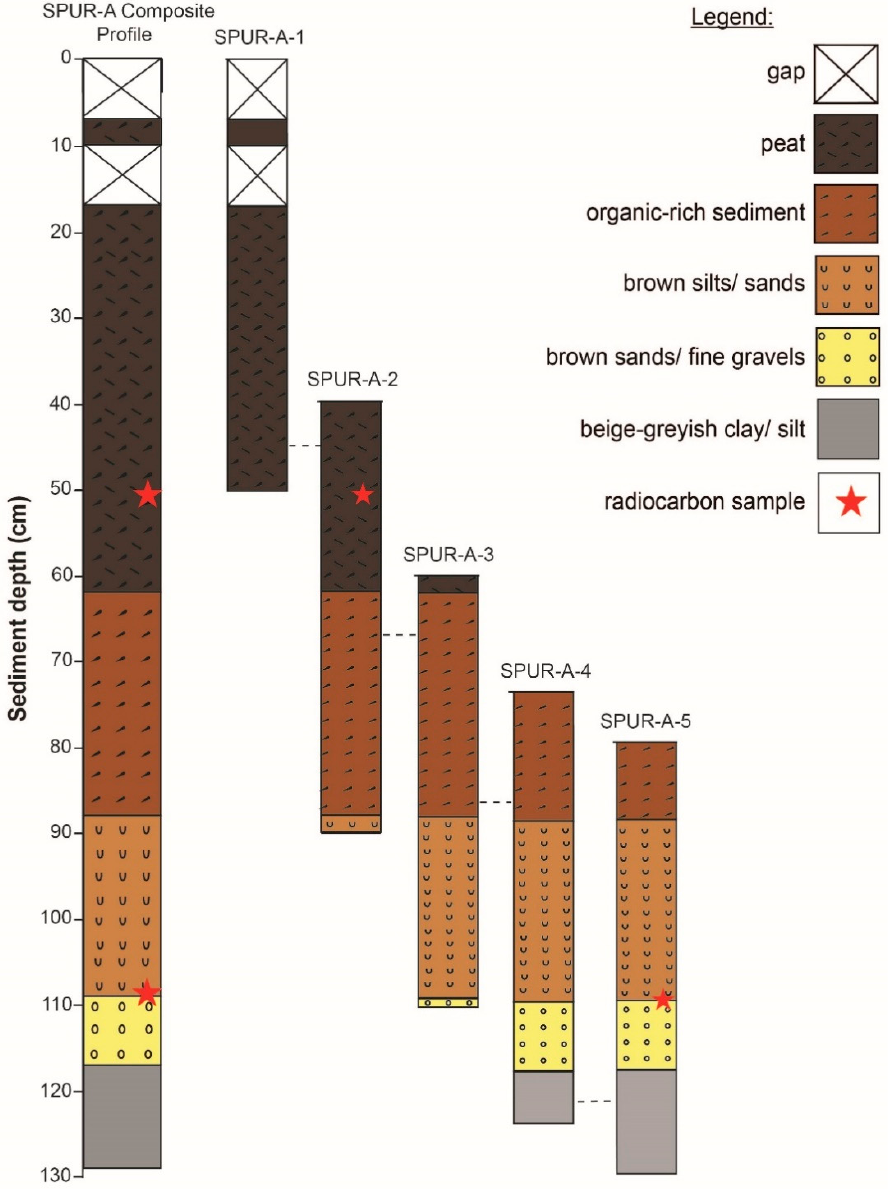
Figure 5. Lithology of composite profile SPUR-A, composed of five overlapping sediment cores SPUR-A-1 to SPUR-A-5 from Spur Bog, and positions of plant macrofossils sampled for radiocarbon